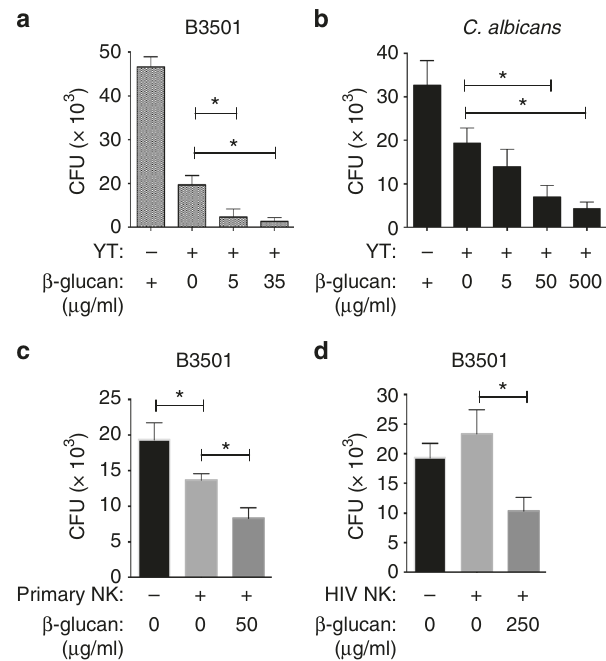
Fig. 2 β -1,3-glucan enhances killing by NK cells from healthy subjects and HIV patients. a YT cell killing of C. neoformans in the presence of β -1,3- glucan (CFU). YT cells were treated with 0, 5, and 35 μ g/ml of soluble β - 1,3-glucan (laminarin derived from L. digitata ) for 4 h before the addition of C. neoformans (strain B3501). CFU were determined in quadruplicate ± SEM. b YT cell killing of C. albicans in the presence of increasing doses of β - 1,3-glucan (0, 5, 50, and 500 μ g/ml). c Primary NK cell killing of C . neoformans (B3501) in the presence of β -1,3-glucan (0 and 50 μ g/ml) for NK cells from healthy subjects. d Killing of C. neoformans (B3501) by primary NK cells from HIV-infected individuals in the presence of β -1,3- glucan (0 and 250 μ g/ml). All experiments were performed for three to fi ve times with similar results. *, p < 0.05. Data were analyzed using